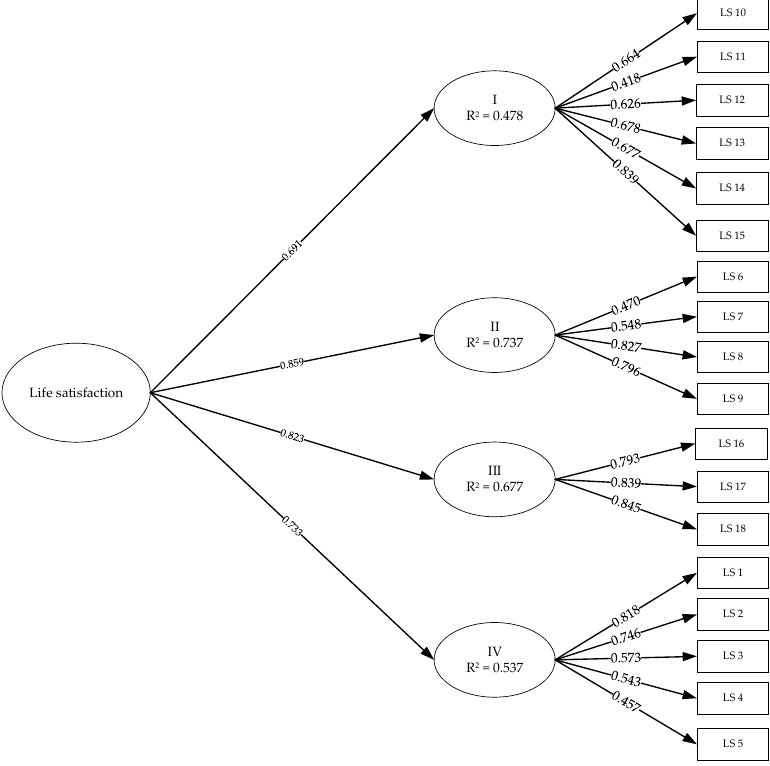
Figure 1. LS structural model. χ 2 = 105.208, df = 106, χ 2 / df = 0.993, p = 0.503, GFI = 0.960, AGFI = 0.936, RMSEA = 0.000 and RMR = 0.039. Table 3. Construct validity of first and second order CFA results.